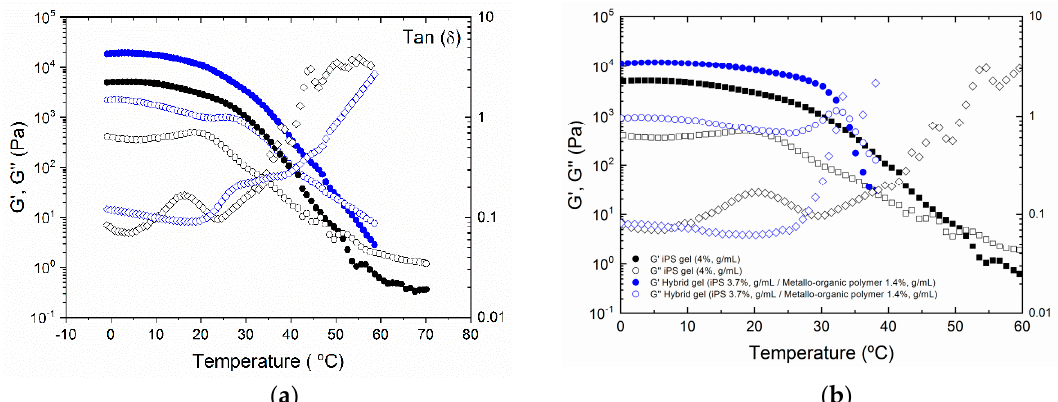
Figure 4. Storage (full symbols) and loss (empty symbols) modulus as a function of oscillation torque measured for: ( a ) Pure iPS gel, 4%, g/mL (black), hybrid gel (blue) with a fixed concentration of iPS (4%, g/mL) and variable concentration of metallo-organic polymer (5.1%, g/mL) and ( b ) pure iPS gel, 4%, g/mL (black), and representative hybrid gel (blue) with a fixed concentration of metallo-organic polymer (1.4%, g/mL) and variable concentration of iPS (4%, g/mL).